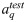
Comparing color sensations for real and predicted matching color.Left. Color sensations aqtest, aqcomp[cmatch] and aqcomp[cqpred]. Right. Functions f and g for the regressed parameter value q = qMC. Right, up. Heatmaps for g and f. Right, down. Corresponding side views.